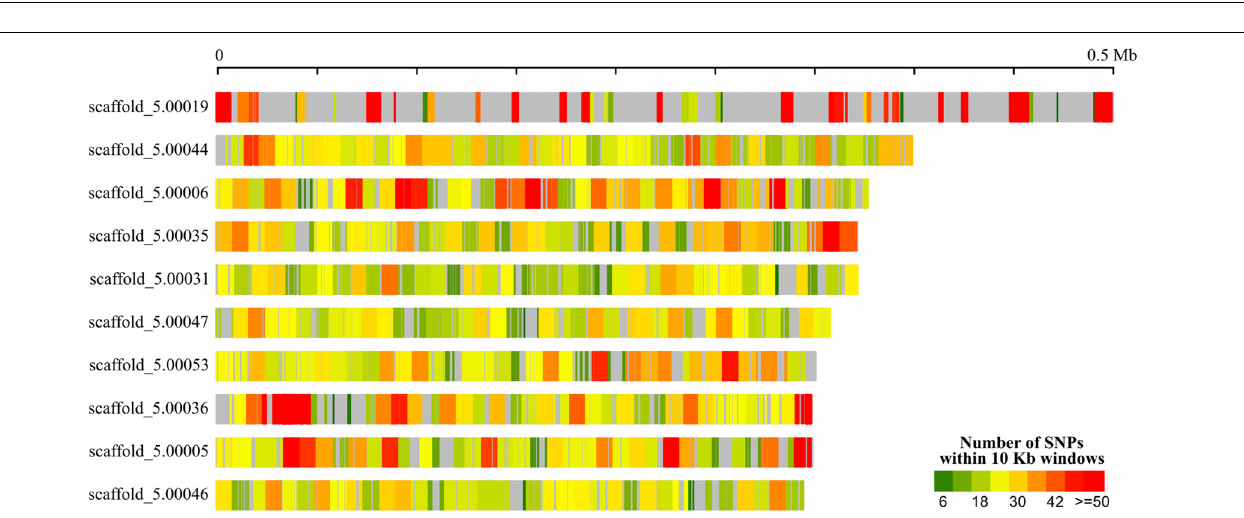
FIGURE 1 | Maximum likelihood phylogenomic tree of Ustilagomycotina species based on 1,637 one-to-one orthologous genes, host information, and genomic features of smut fungi. The scientific names were abbreviated according to Table 1 . The colors assigned to each species distinguish plant pathogens (green), human pathogens (blue), and species from distinct environmental niches (orange). Double bars at the tree root indicate out of scale.